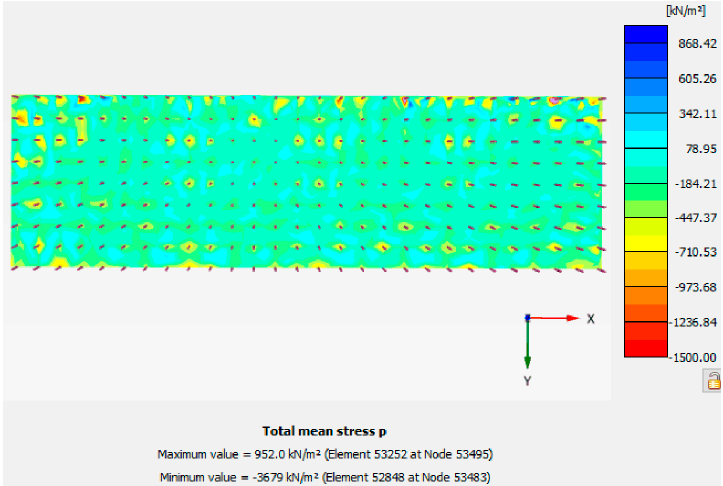
Figure 10. Principal stress nephogram in the cushion layer.